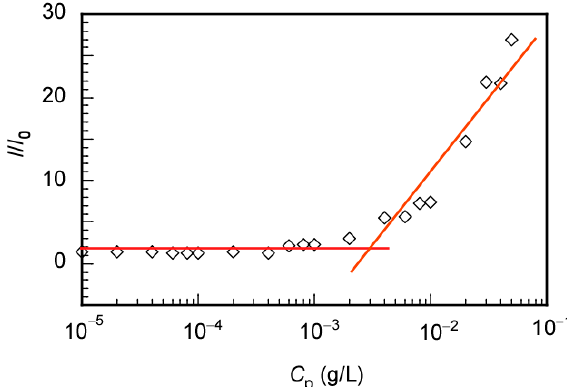
Figure 4. Light scattering intensity ratio ( I / I 0 ) for the P(VS) 17 A 50 /PAAc 49 PIC vesicle in water pH 10 as a function of polymer concentration ( C p ). I and I 0 are the light scattering intensities of the PIC vesicle solution and solvent, respectively.